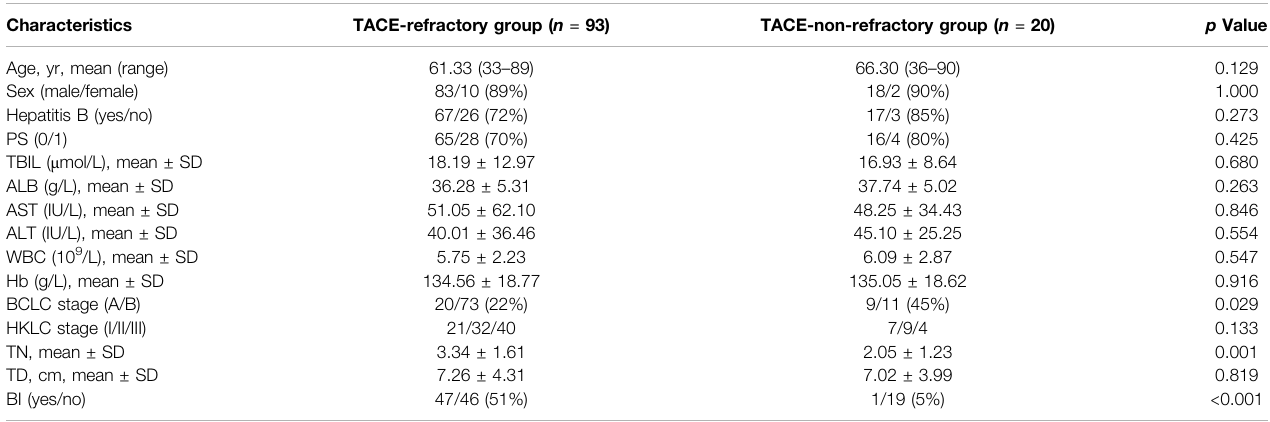
TABLE 1 | Baseline characteristics in the study cohort. Characteristics